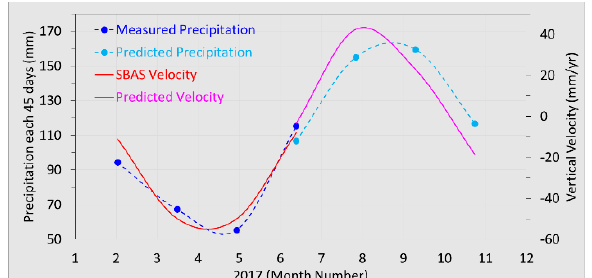
Figure 11. Predicted precipitations and velocities (second half) from measured precipitations and SBAS velocities (first half) via predictive model. Measured precipitations are accumulated every 45 days from daily measurements (Figure 8).